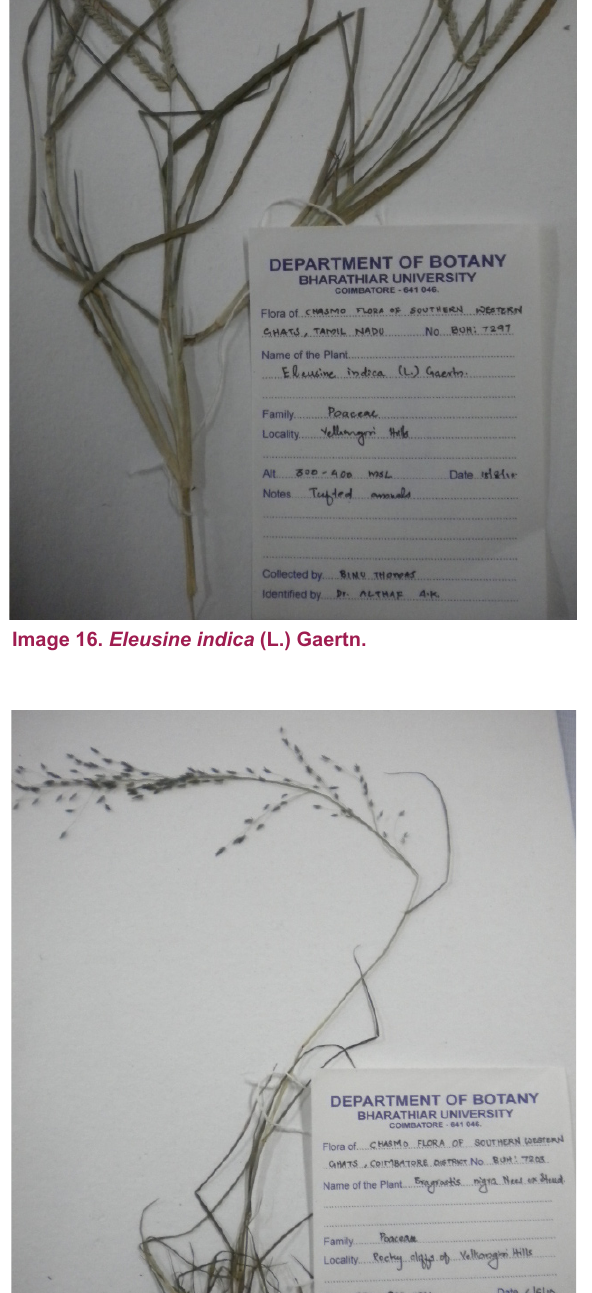
Image 19. Eragrostis tenella (L.) P.